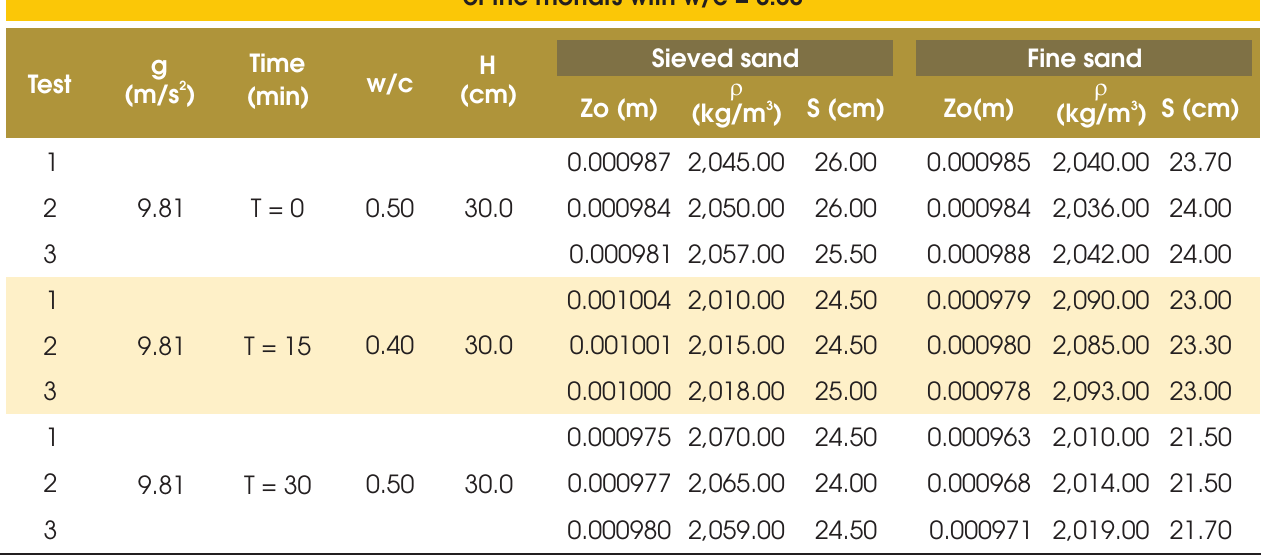
Table 11 – Method of Pashias: parameters needed to calculate the yield stress of the mortars with w/c =